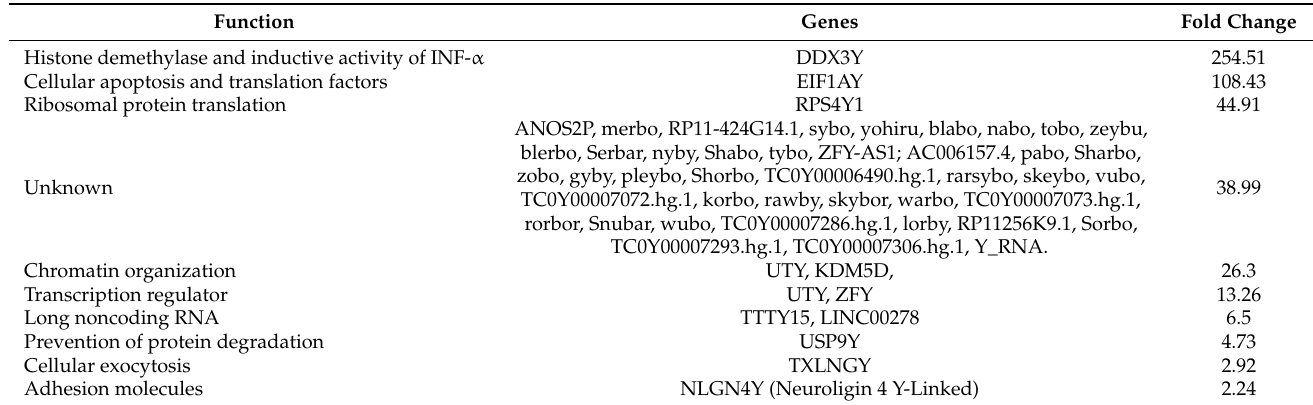
Table 1. Transcripts expressed in Y